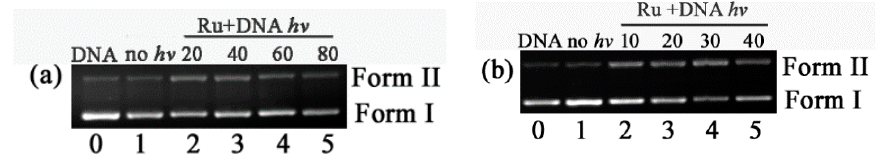
Figure 5. Photoinduced cleavage of pBR322 DNA (0.1 µ g) by complex 1 ( a ) and 2 ( b ) (20 µ M) after 2 h irradiation. Lane 0: DNA only, no hv; lane 1: DNA + Ru(20 µ M), no hv; lane 2–5: DNA + Ru, hv.